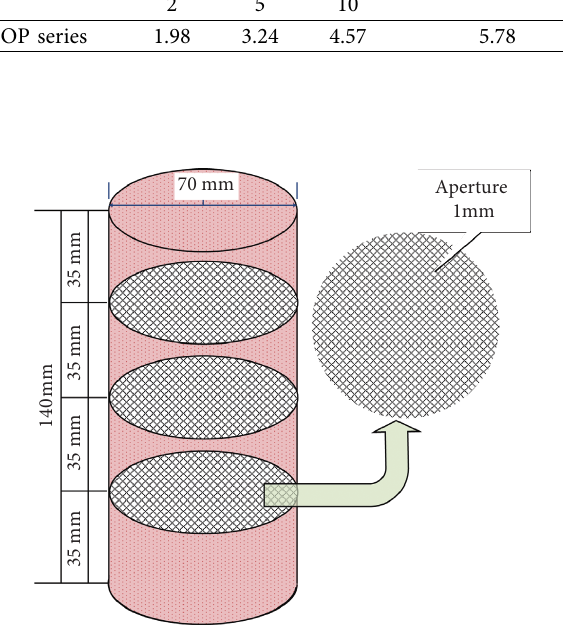
Figure 4: Sample reinforcement distribution and reinforcement grille gap diameter.